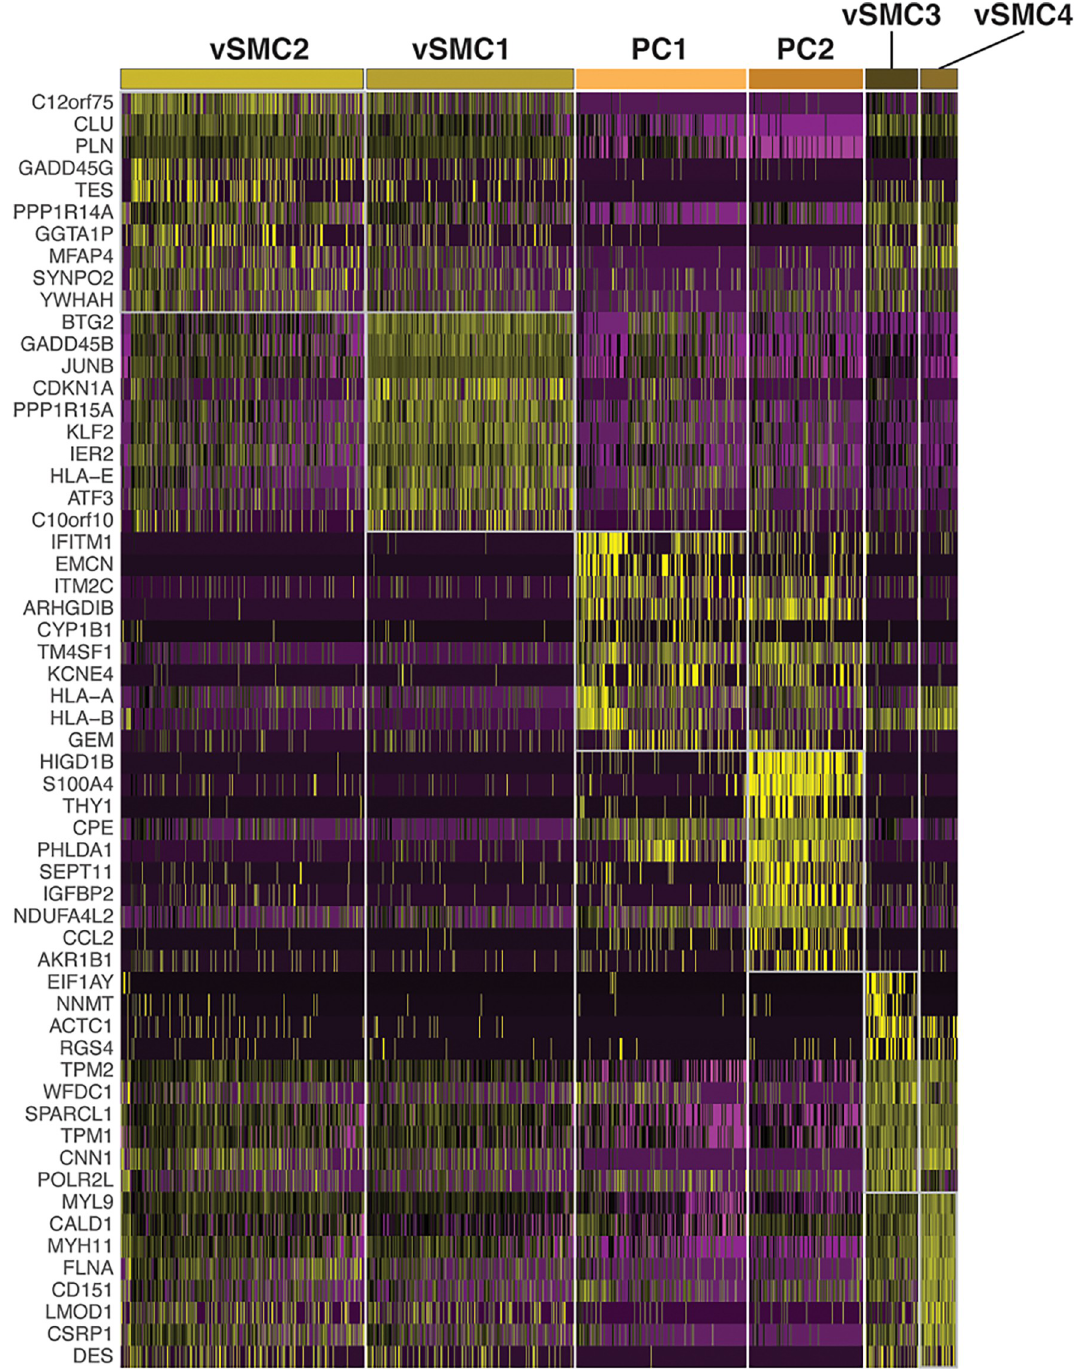
Fig 8. Differential gene expression in pericytes and vascular smooth muscle cells. Figure depicts heatmap of differentially expressed genes in pericytes and vascular smooth muscle cells.